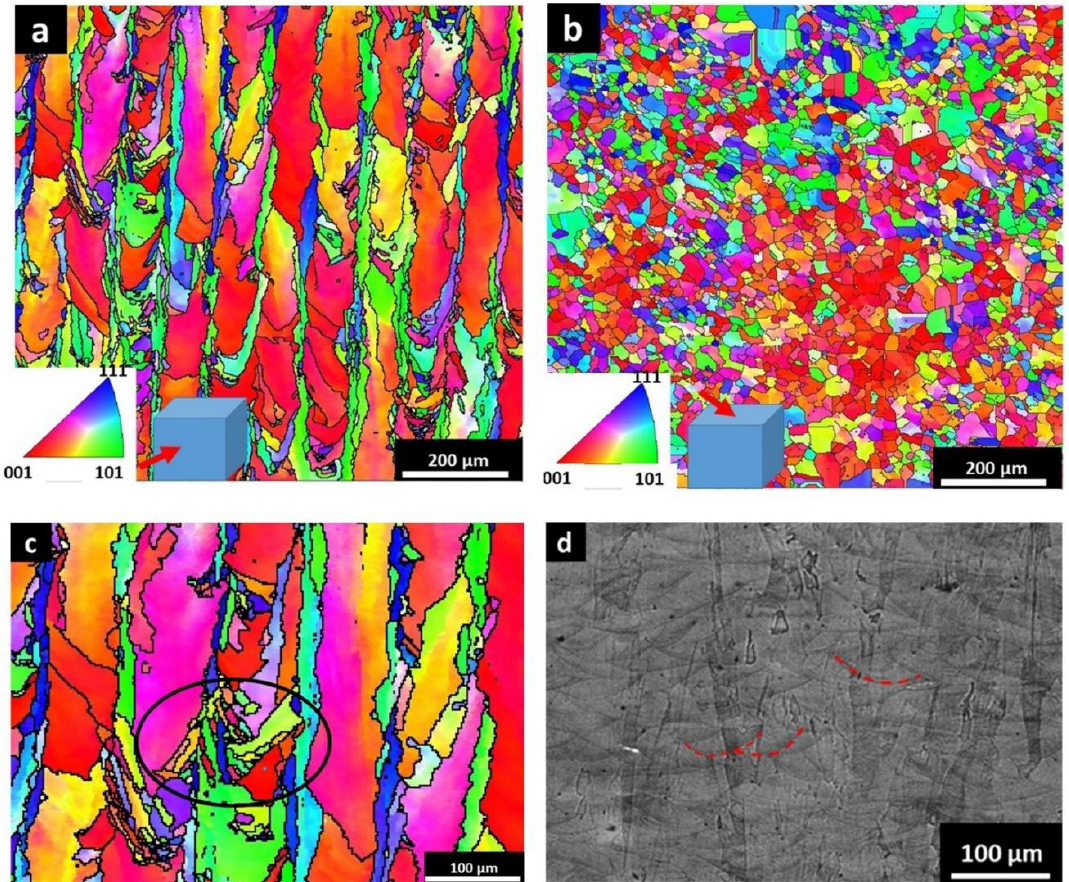
Figure 9. ( a , b ) Electron backscatter di ff raction (EBSD) maps with included inverse pole figure of LPBFed IN939 sample (S38) along the building direction ( z -axis) and perpendicular to the building direction ( xy plane), respectively; high angle grain boundaries ( > 10 ◦ ) are marked by black line segments; ( c ) Zoom of the EBSD map along z -axis showing the presence of smaller grains triggered by melt pools; ( d ) Chemical etched LOM image of the LPBFed IN939 showing columnar grains and the melt pools, some of which are pointed out by red lines, along the building direction.